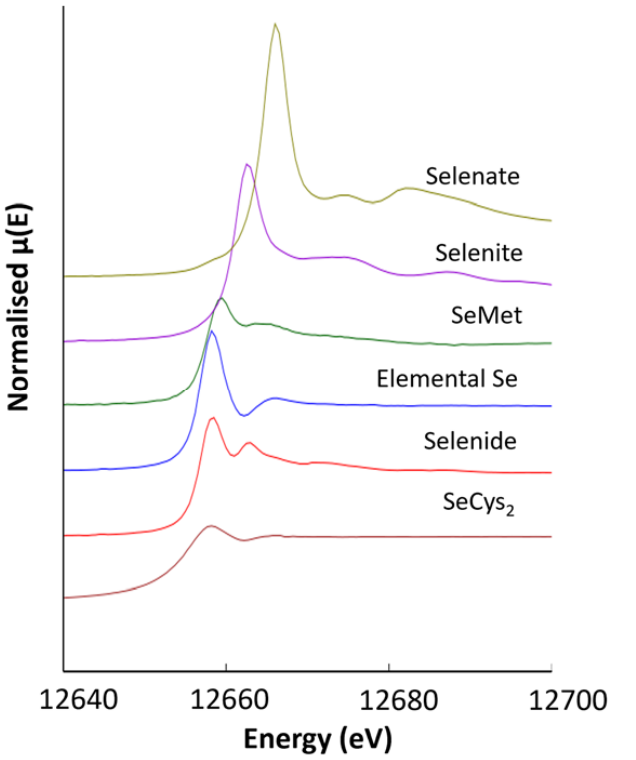
Figure 5. Normalised XANES spectra for inorganic and organic selenium standards in the oxidation states ‐ II, 0, IV and VI.